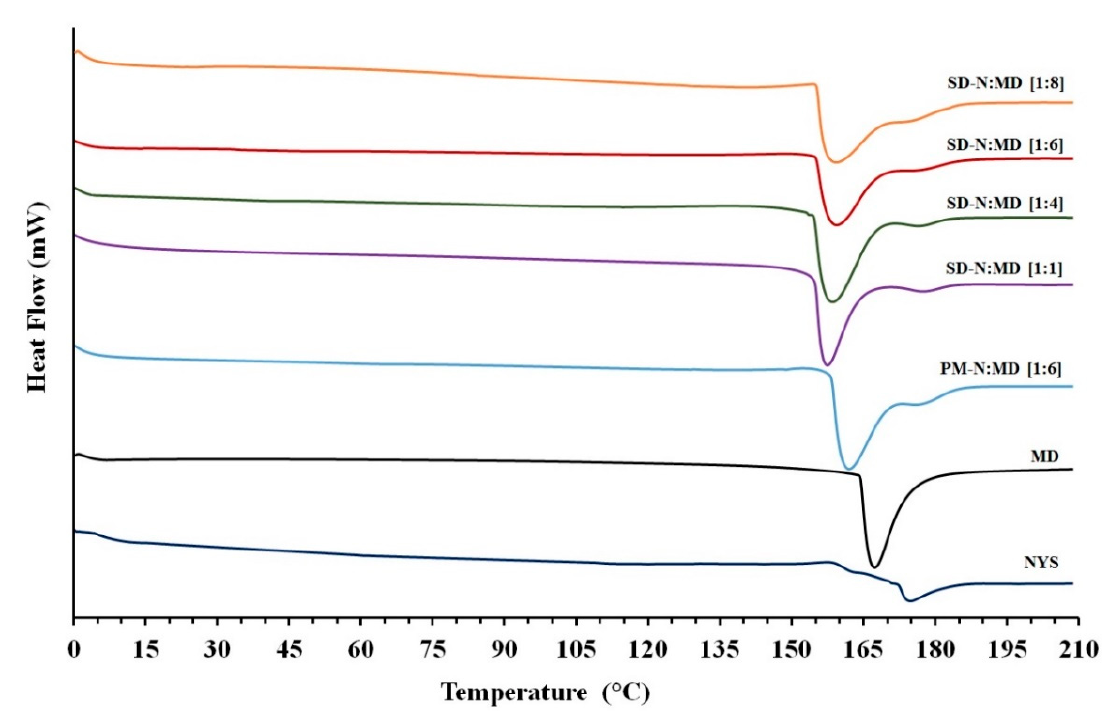
Figure 3. DSC thermograms of nystatin raw material (NYS), maltodextrin (MD), PM-N:MD [1:6] physical mixture, and SD-N:MD [1:1], SD-N:MD [1:4], SD-N:MD [1:6], and SD-N:MD [1:8] solid dispersions.